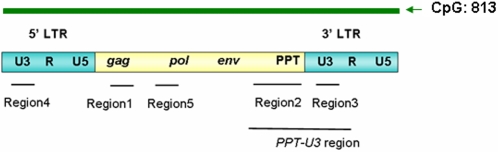
Four conserved regions (region1∼4) on ALVEs and one unique region (region5) of ALVE1 for pyrosequencing and real-time RT-PCR.5′LTR: 5′ long terminal repeat; U3: U3 region in LTR; R: R region in LTR; U5: U5 region in LTR; gag: gag gene; pol: pol gene; env: env gene; PPT: polypurine tract; 3′LTR: 3′ long terminal repeat of ALVE. PPT-U3 region: combined PPT and U3 regions for real-time RT-PCR. Green arrow shows the CpG islands that including 813 CpG sites within 7525 bp of ALVE1 (Blat result from UCSC Genome Browser website).